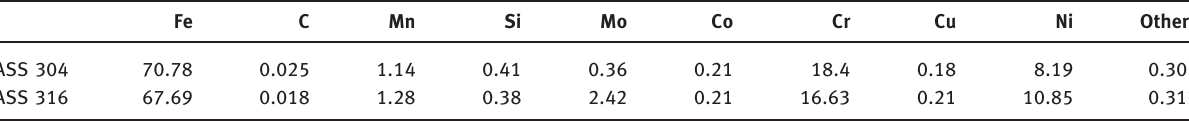
Table 1: Chemical composition of ASS 304 and 316 (wt.%). Fe